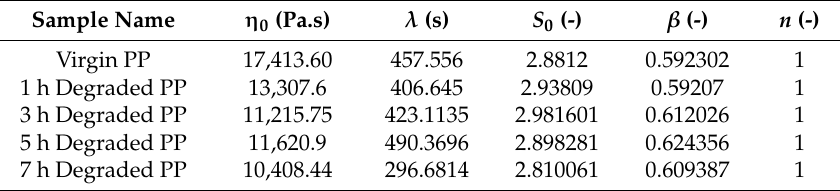
Table 5. Extended Yao model parameters for T = 180 ◦ C.